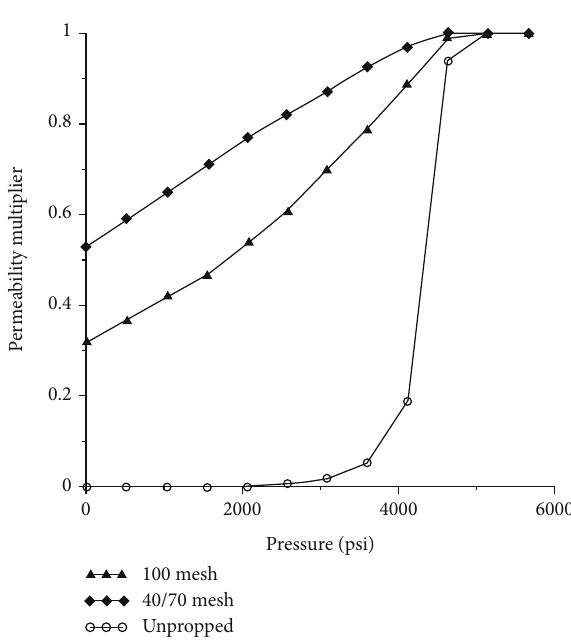
Figure 15: Pressure-dependent permeability